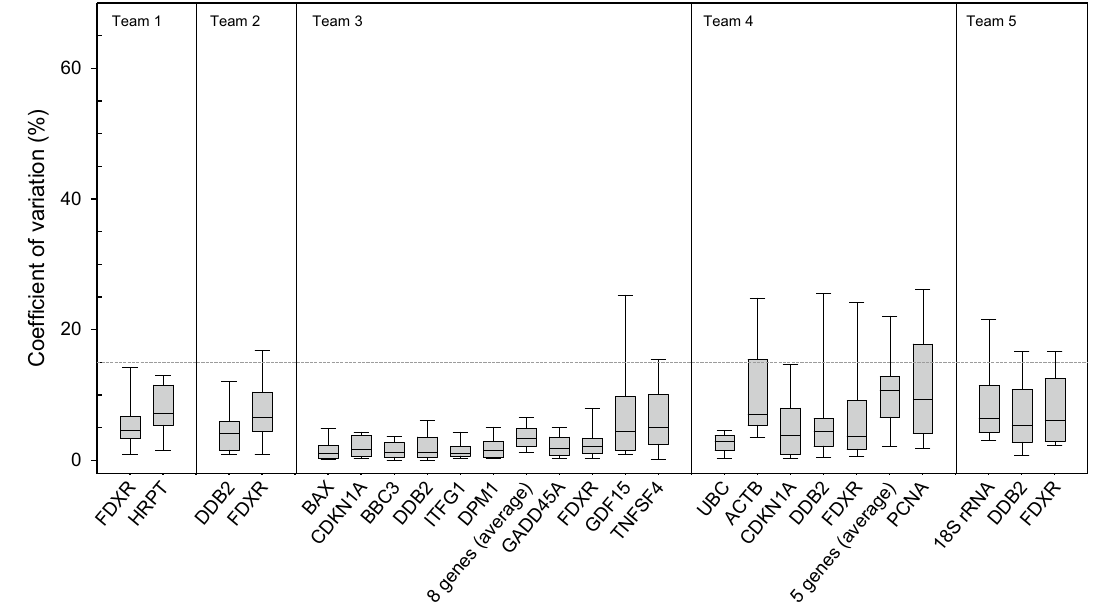
Figure 2. The coefficient of variation (CV) was calculated based on all available technical replicates and genes. The distribution of CVs per gene is reflected by a box plot showing the 10th (lower whisker), 25th (lower end of the box), 50th (median, straight line), 75th (upper end of the box) and 90th (upper whisker) percentiles. Genes are ordered with increasing normalized Ct-values. Teams are arbitrarily numbered from one to five. The horizontal spotted grey line refers to the 15% CV and shows that most measurements are lying below this value (graph created using SigmaPlot Version 14.0, http:// www. systa tsoft ware.